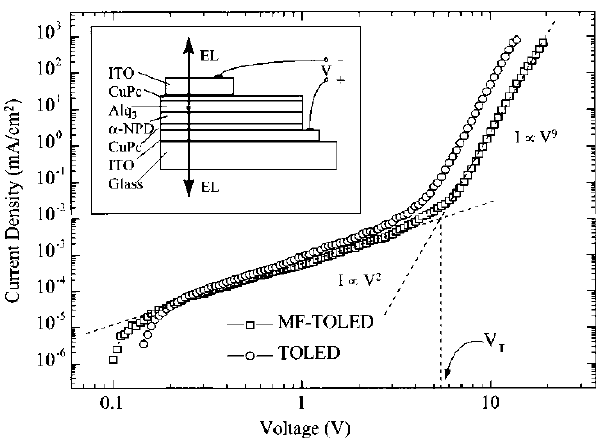
Figure 15. Current-voltage characteristics of a 0.4 mm diameter metal-free transparent organic light-emitting device (MF-TOLED) and TOLED has grown in the same vacuum cycle. Inset: schematic illustration of the MF-TOLED structure. Reprinted with permission from ref. [86]. 1998 American Institute of Physics.